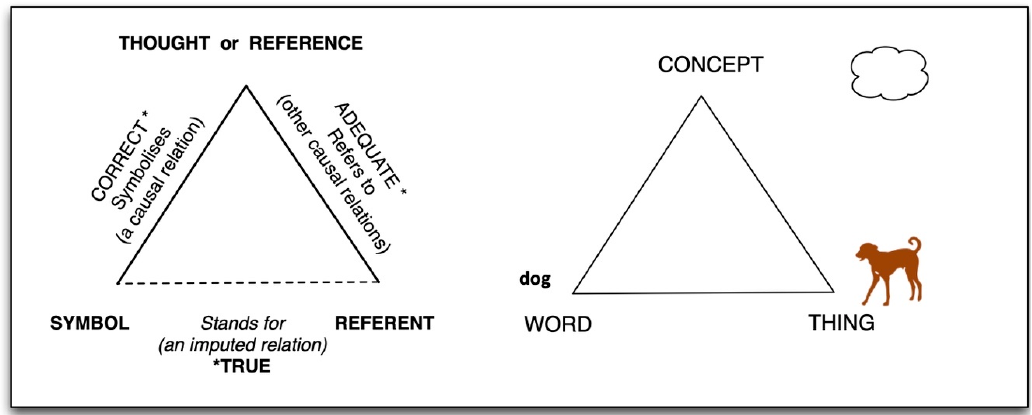
Figure 2. The semiotic triangle according to Ogden and Richards [37]: The word (Symbol), the thing (Referent), and the concept (Thought) are connected.